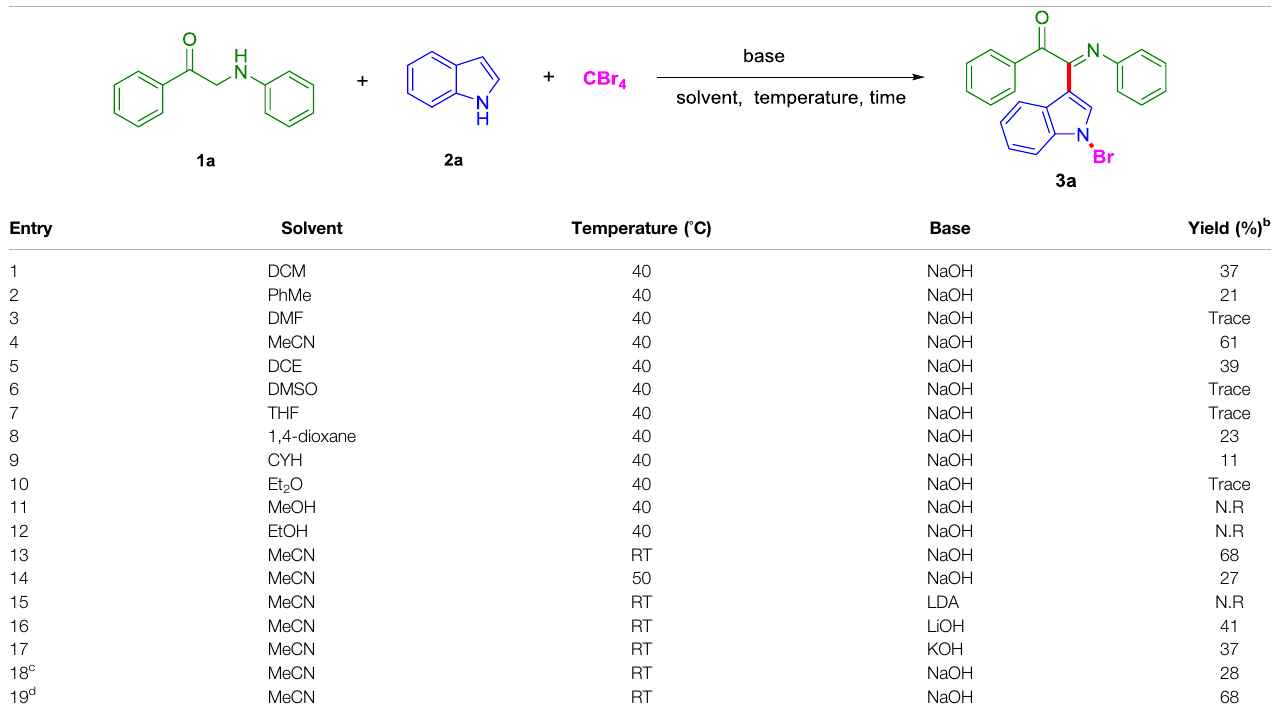
TABLE 1 | Optimization of the reaction conditions.